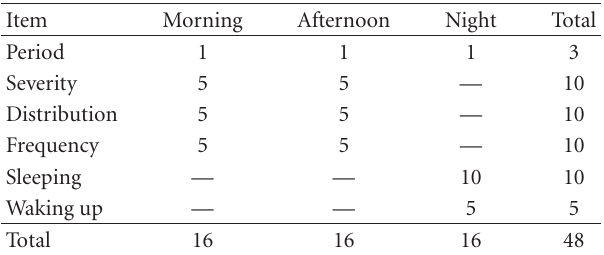
Table 1: Pruritus-pointing system.